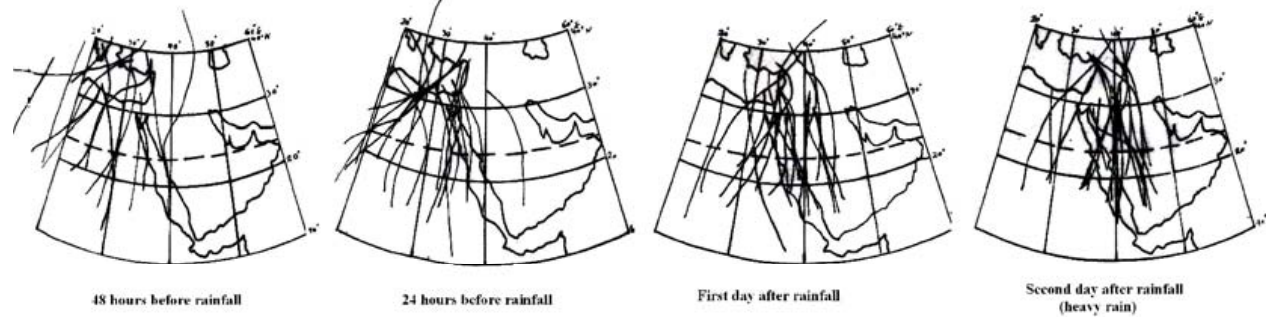
Fig. 23. Trough lines at 500hPa level, before the rainfall (left pictures) and in first day and second day of heavy rainfalls (right Fig. 23 Trough lines at 500 hPa level, before the rainfall (left pictures) and in first day and 2nd day of heavy rainfalls (right pictures)